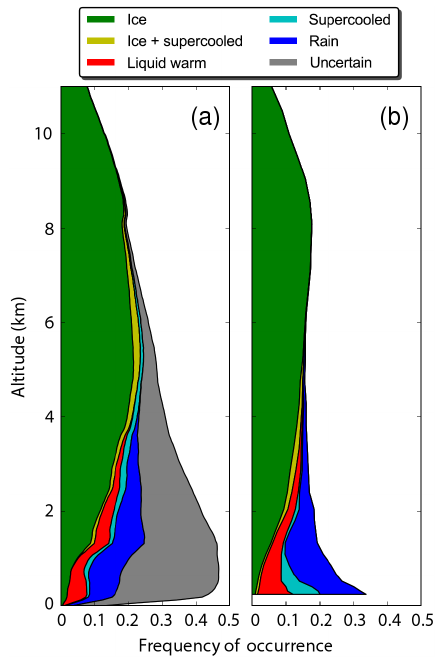
Figure 6. Mean vertical profiles of the different cloud-phase cate- gories (a) returned from the DARDAR-MASK and (b) simulated by the WRF-Chem model between 4 and 21